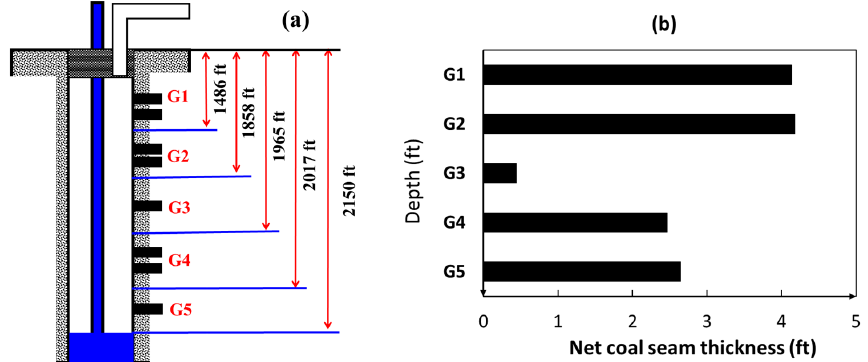
Figure 3. Water levels from Echometer tests ( a ) and net thickness of water-covered coal seams in each test ( b ). G1–G5 represents five individual groups of coals for each test, blue color represents water/water level in the CBM well, and black bar represents net coal seam thickness in each group.